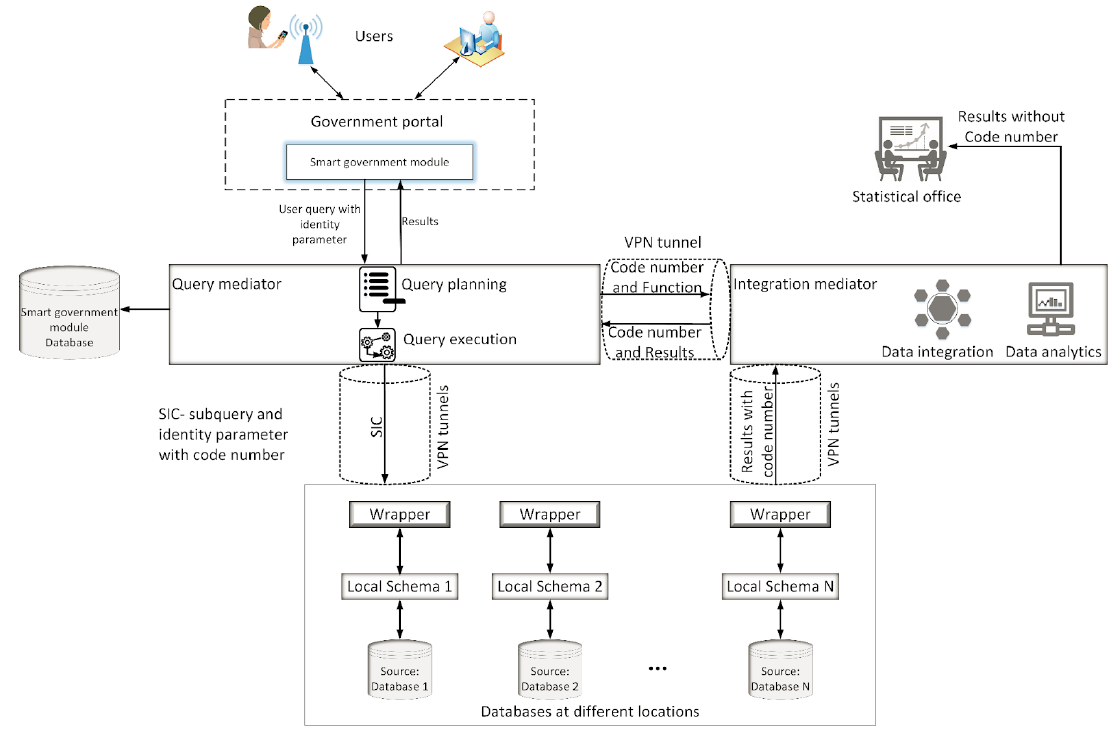
Figure 1. The design of the proposed model.